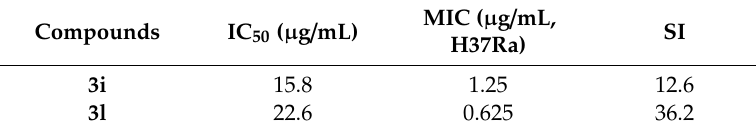
Table 5. Cytotoxicity of compounds 3i and 3l against cell line